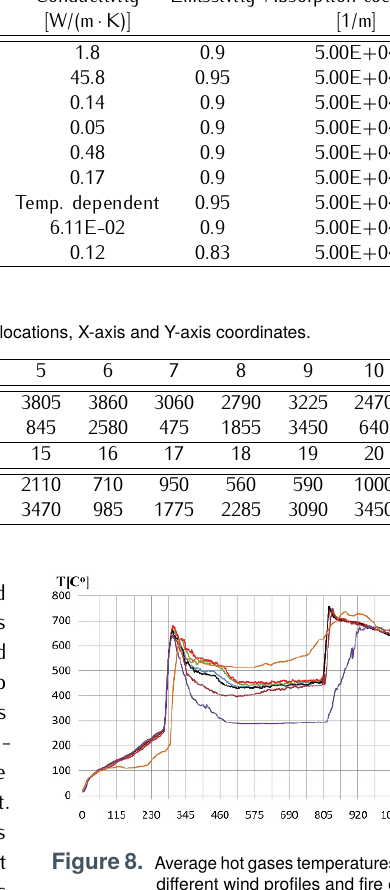
dow’s pane breakage at 801 seconds a fire grow appears again and it continues till 900 seconds. The final period shown on Fig. 8 after 900 second, describes the correla- tion of continuous decay of HRR and decay of average sensors temperature till South pane breakage of Window 1 at 1111 seconds. Evidently there is a correlation between the temperature and the HRR as show on Fig. 8.